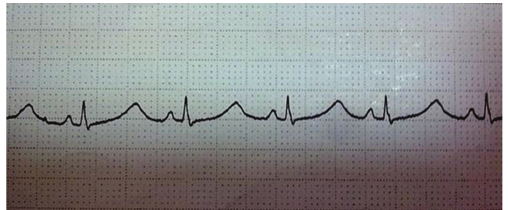
Figure 1: ECG of the patient (cQT 600msec).